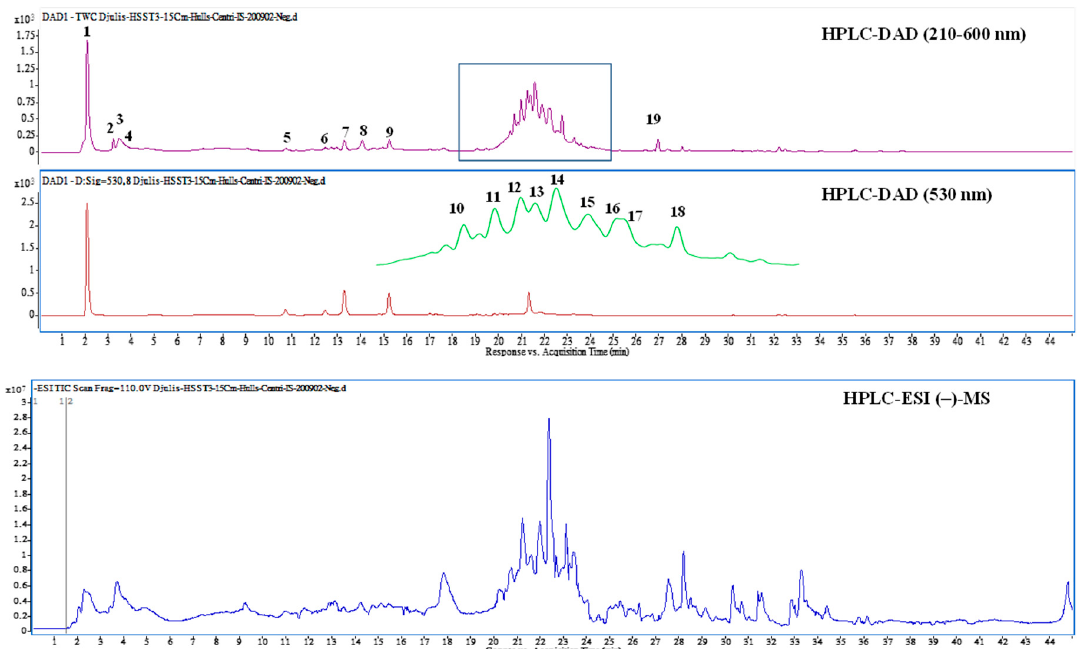
Figure 3. High-performance liquid chromatograms detected at a full UV-Vis spectrum of 210–600 nm (top) and UV 530 nm (middle), and the total ion chromatogram of negative ionization mass spectrometry (bottom) from ethanolic extracts of djulis husk.